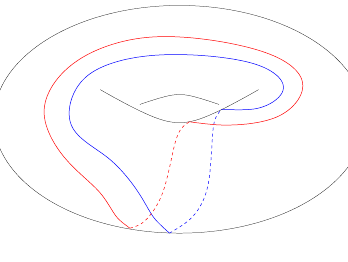
Figure 2: Foliation of T 2 by (1, 1) -circles.